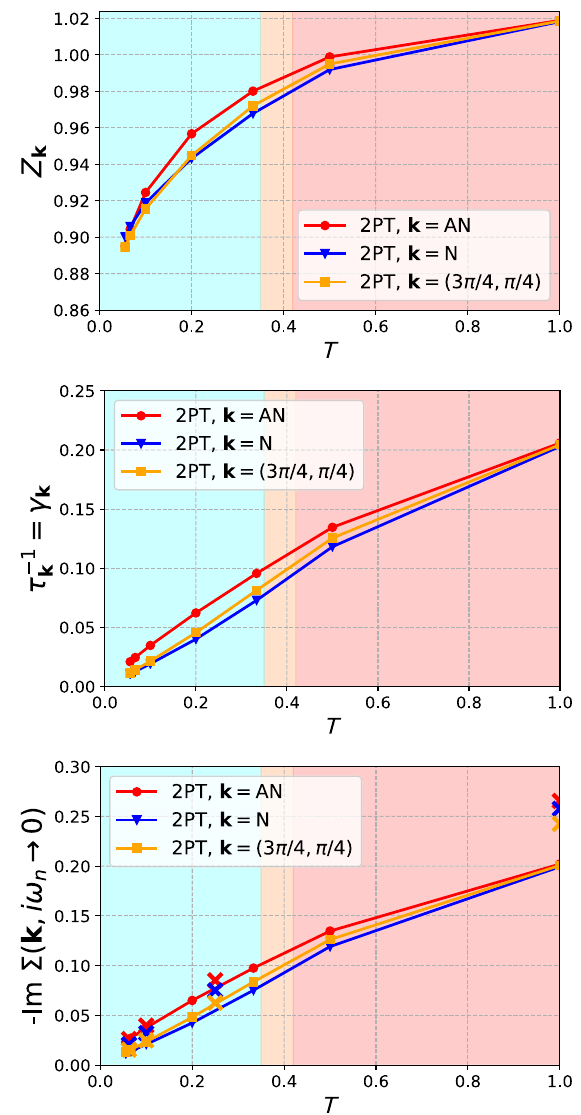
FIG. 32. Quasiparticle parameters Z k (upper panel) and γ k (middle panel) and the imaginary part of the self-energy extrapo- lated to zero frequency (lower panel) at the antinode (red circles), node (blue triangles), and k ¼ ð 3 π = 4 ; π = 4 Þ (orange squares) in second-order perturbation theory as a function of temperature. The values for the crosses in the lowest panel have been obtained directly from the real-frequency